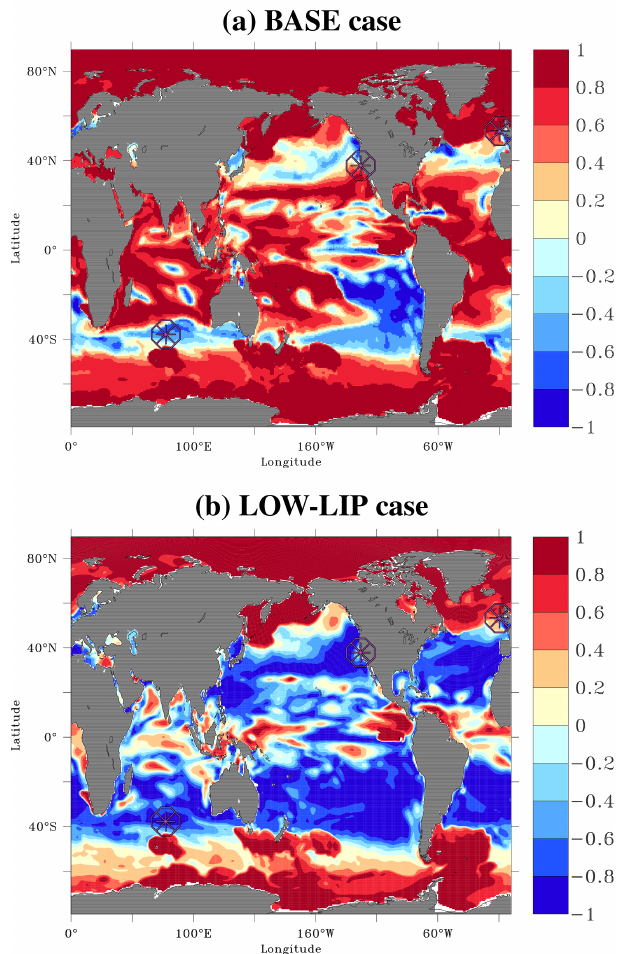
Figure 12. Correlation between POP-simulated monthly mean chl a and predicted monthly mean organic mass fraction for 1 simulated year, for the BASE case and LOW-LIP case. Stars indicate the loca- tions of Mace Head, Ireland; Point Reyes, California; and Amster- dam Island (Southern